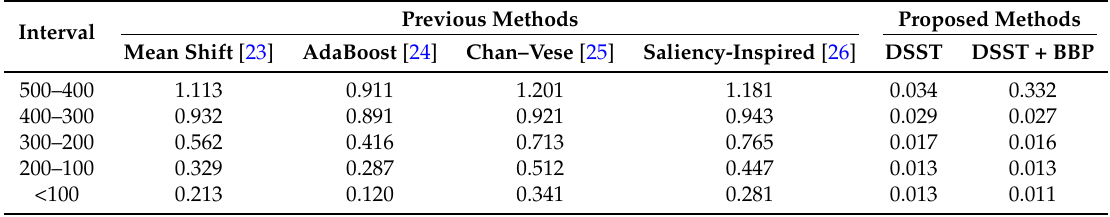
Table 7. Errors (m) in the i O , c -axis with tracking algorithms at separate intervals